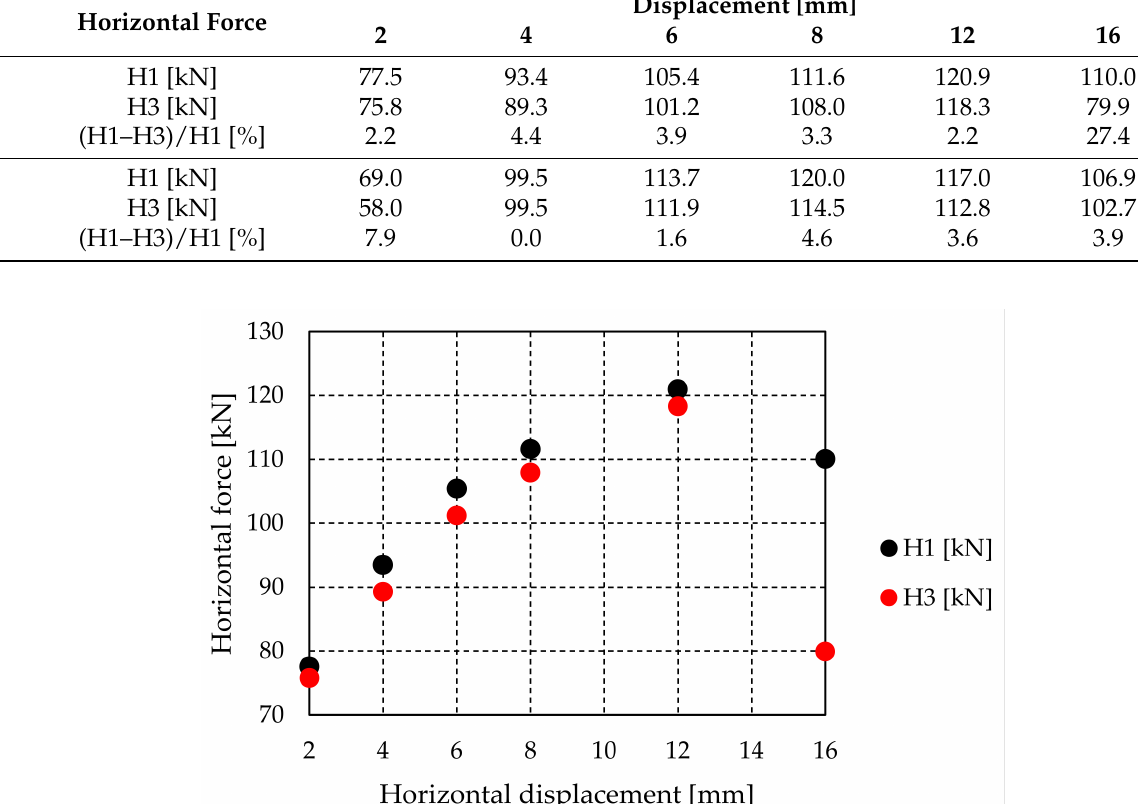
Figure 15. Degradation of shear resistance for repeated loading for